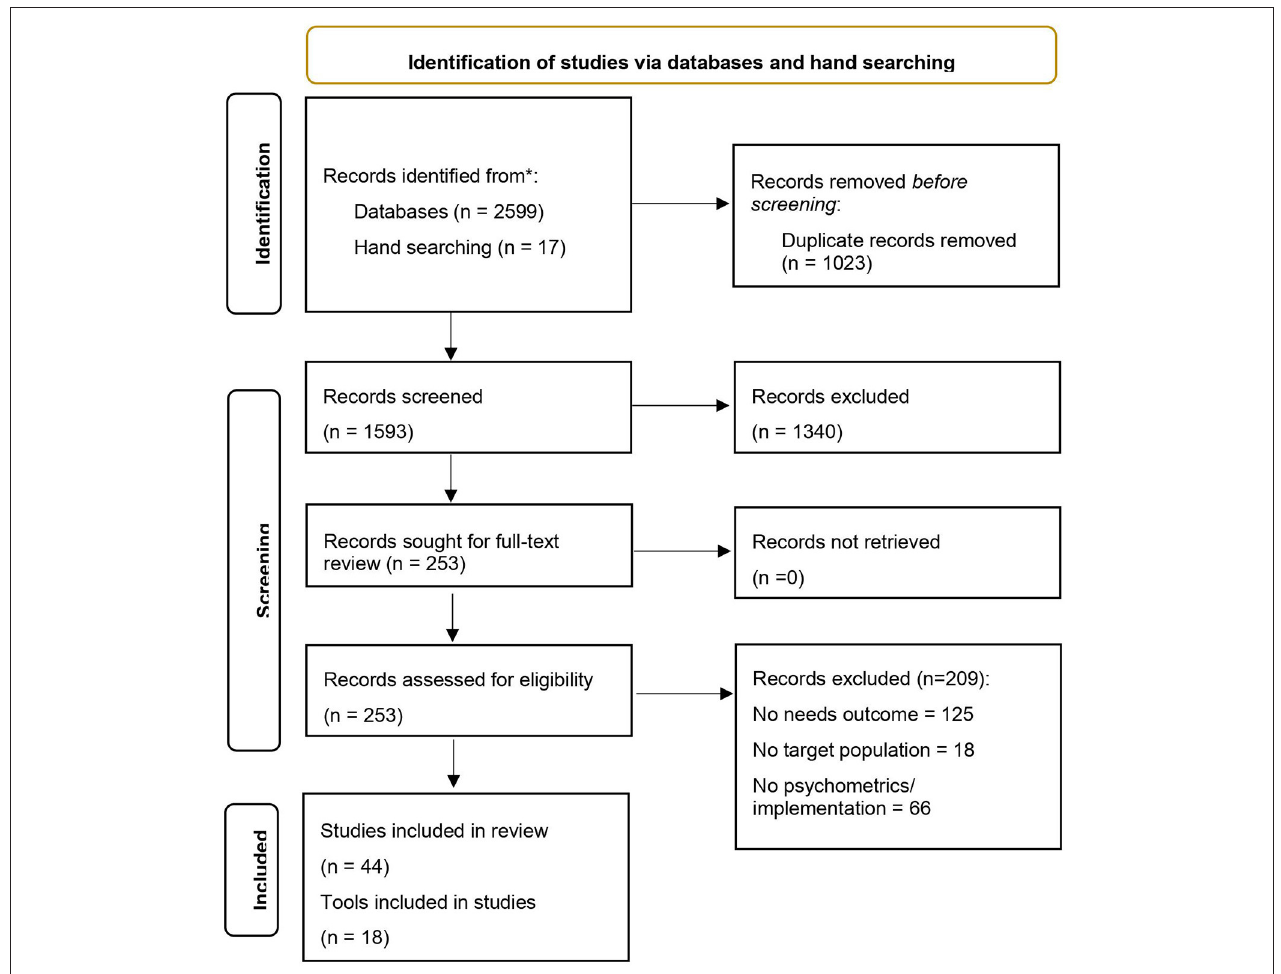
FIGURE 1 | PRISMA flow